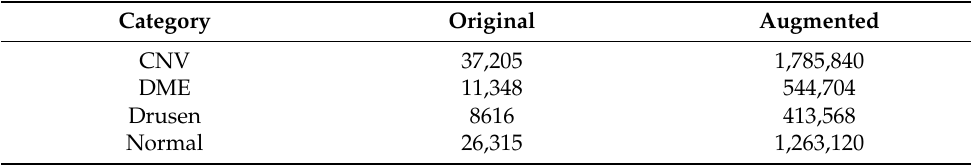
Table 1. Number of training samples for original and augmented